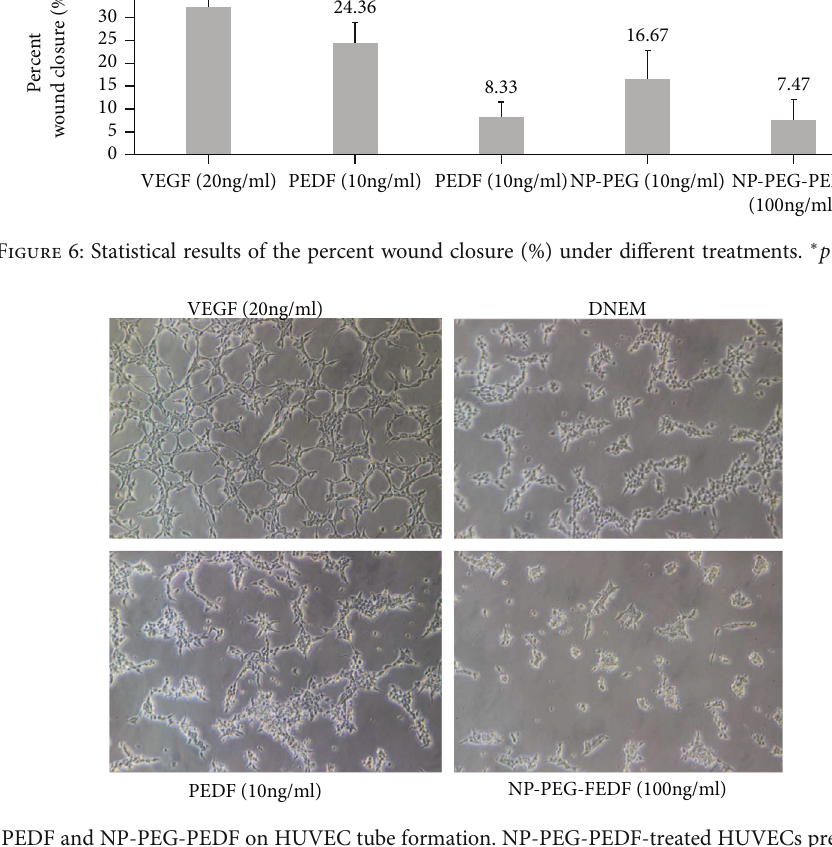
Figure 7: E ff ects of PEDF and NP-PEG-PEDF on HUVEC tube formation. NP-PEG-PEDF-treated HUVECs presented round morphology and showed no cell branches attempting to form